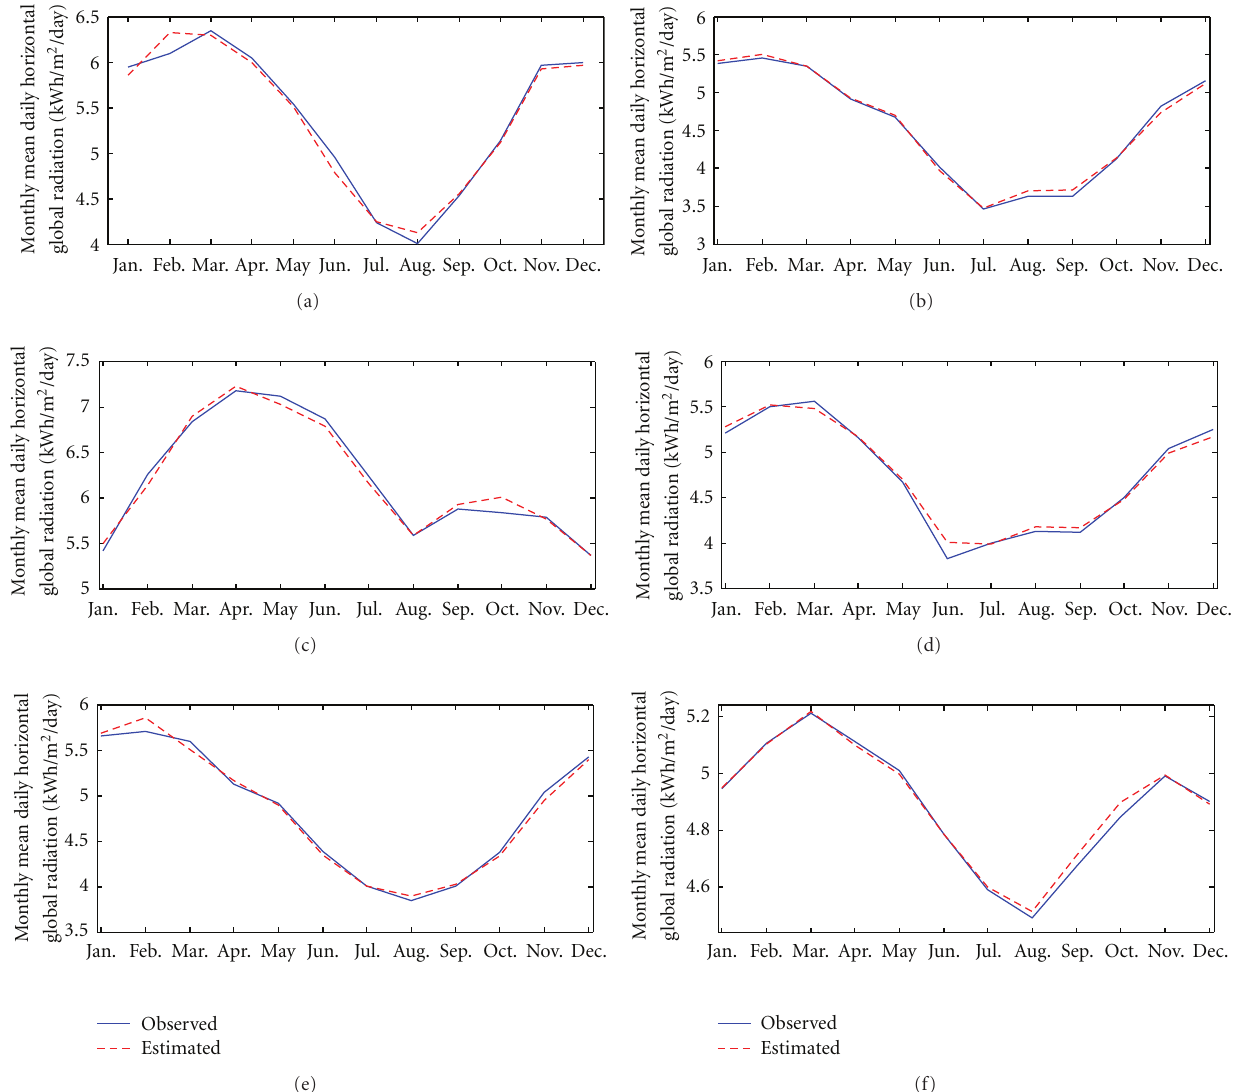
Figure 3: Comparison of the estimated and observed monthly mean horizontal global solar radiation data: (a) Abuja, (b) Benin City, (c) Katsina, (d) Lagos, (e) Nsukka, and (f)